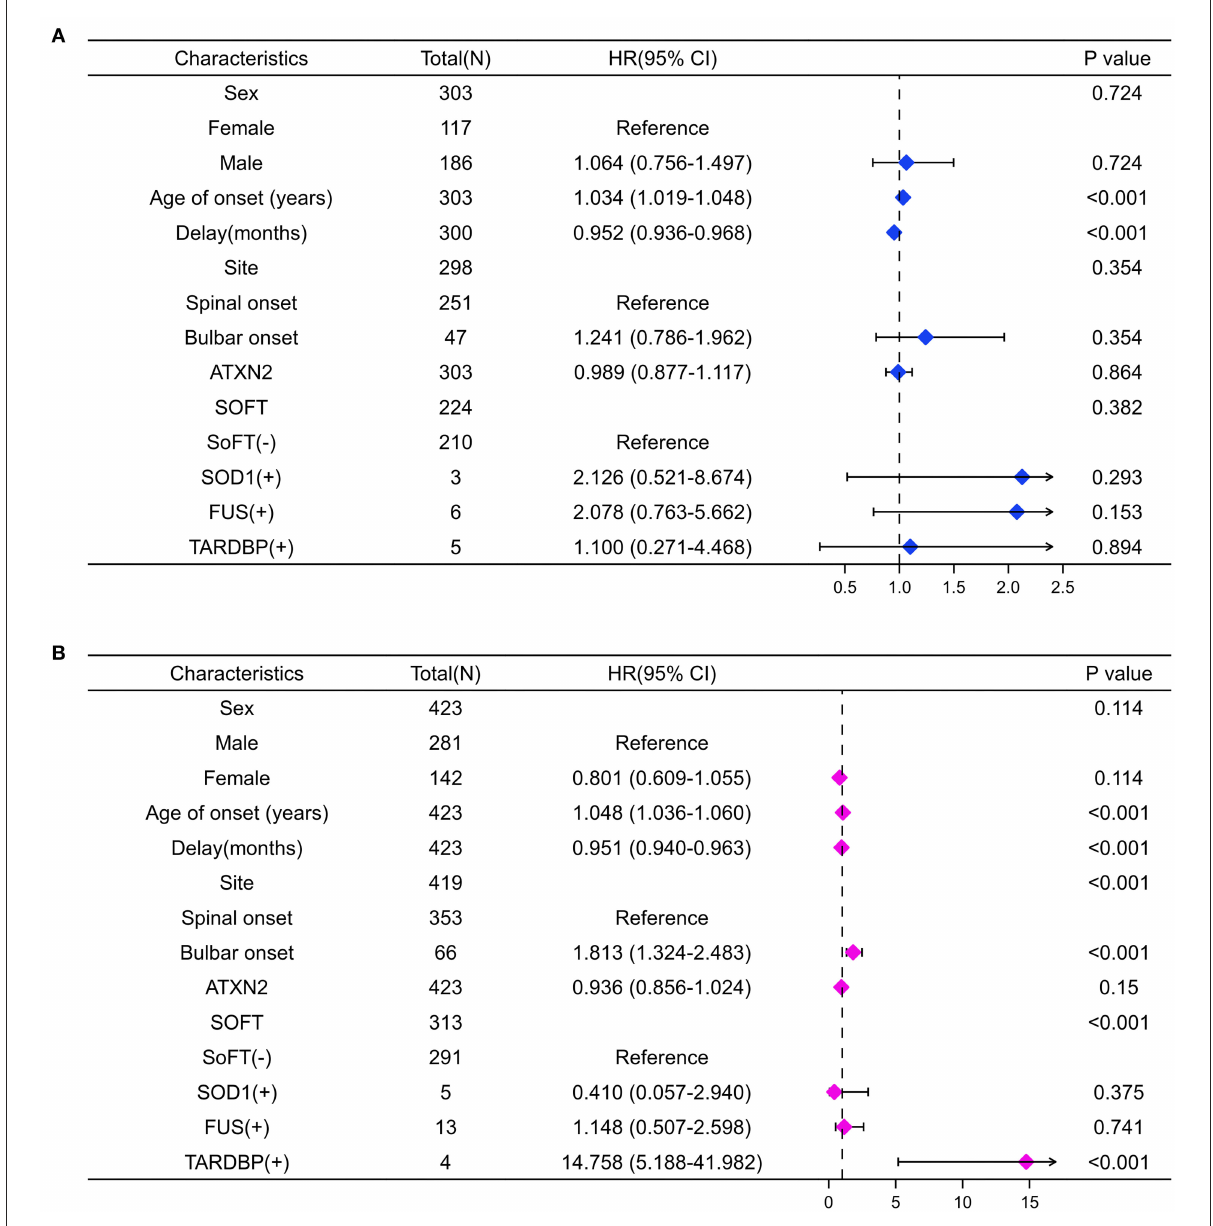
FIGURE4 Forest plots summarize the results of univariate Cox analysis stratifying by C9orf72 repeat length. When MaxC9 = 2 (A) , the age of onset and the delay are associated with the survival of patients (both p < 0.001). When MaxC9 > 2 (B) , besides the age of onset and the delay, the bulbar site of onset and carrying TARDBP mutation are also associated with the survival of patients (all p < 0.001).